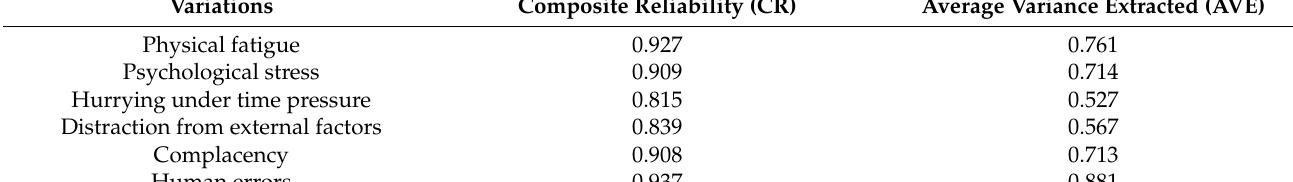
Table 3. Convergence Feasibility Validation.